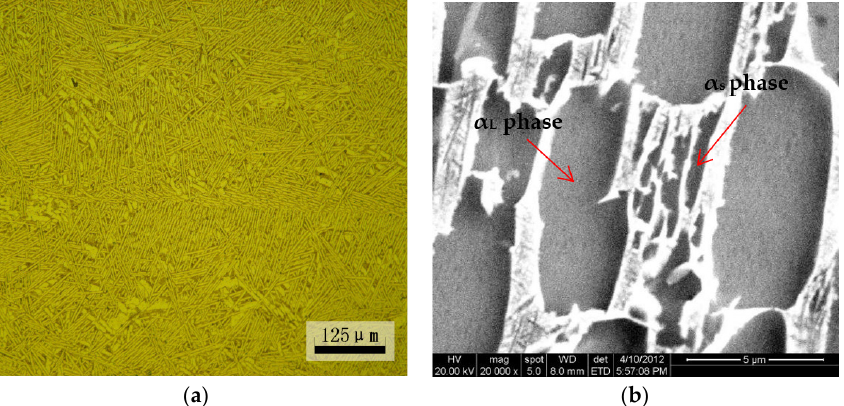
Figure 1. Microstructures of TC21 titanium alloy: ( a ) optical micrograph (OM) and ( b ) backscattered electron micrograph (BEM).